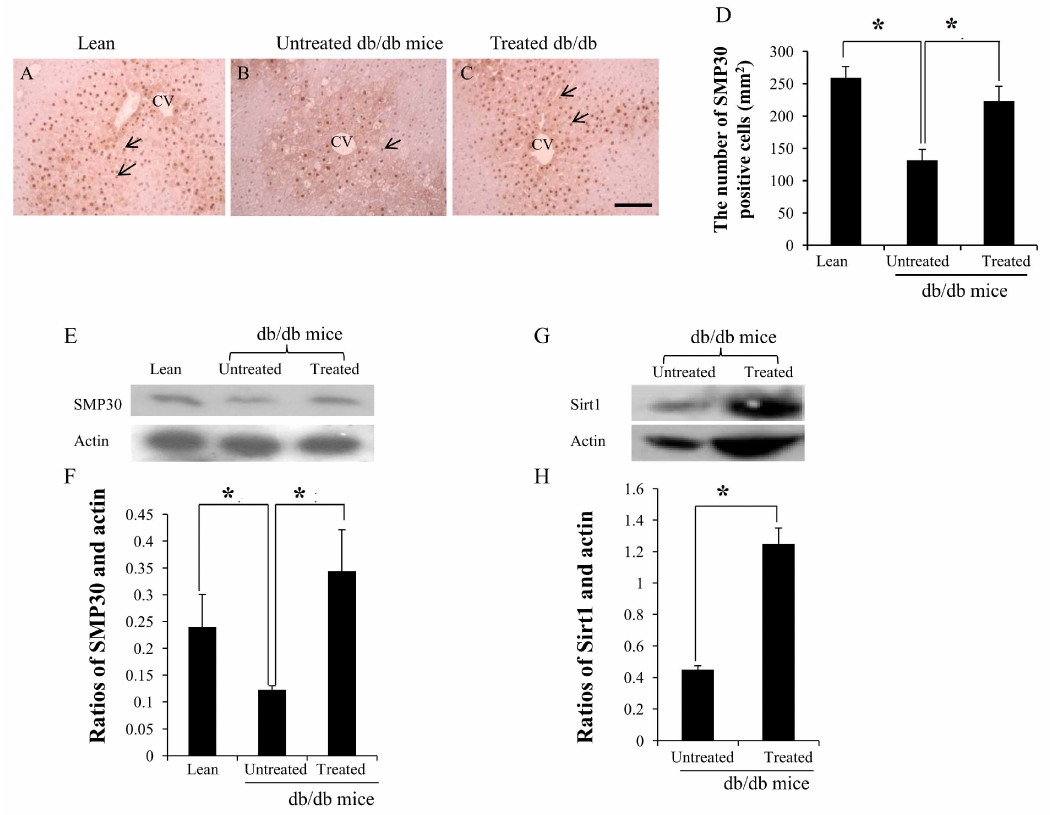
Figure 4. A – D Immunochemistry staining and results of western blotting for SMP30 and Sirt1 in the livers. Expression of SMP30 decreased more in the liver of untreated db/db mice (arrow in B ) than lean (arrows in A ) and treated db/db mice (arrows in C ); The low SMP30-positive cell counts were improved after stem cell replacement. The expression of SMP30 and Sirt1 was measured by western blotting ( E , G ). The ratio of SMP30 and actin, Sirt1, and actin in the treated db/db mice were significantly higher than in the untreated db/db mice ( F , H ). CV: central vein. The results are mean ˘ SD, n = 6 in each group. Scale bar = 25 µ m. * p <